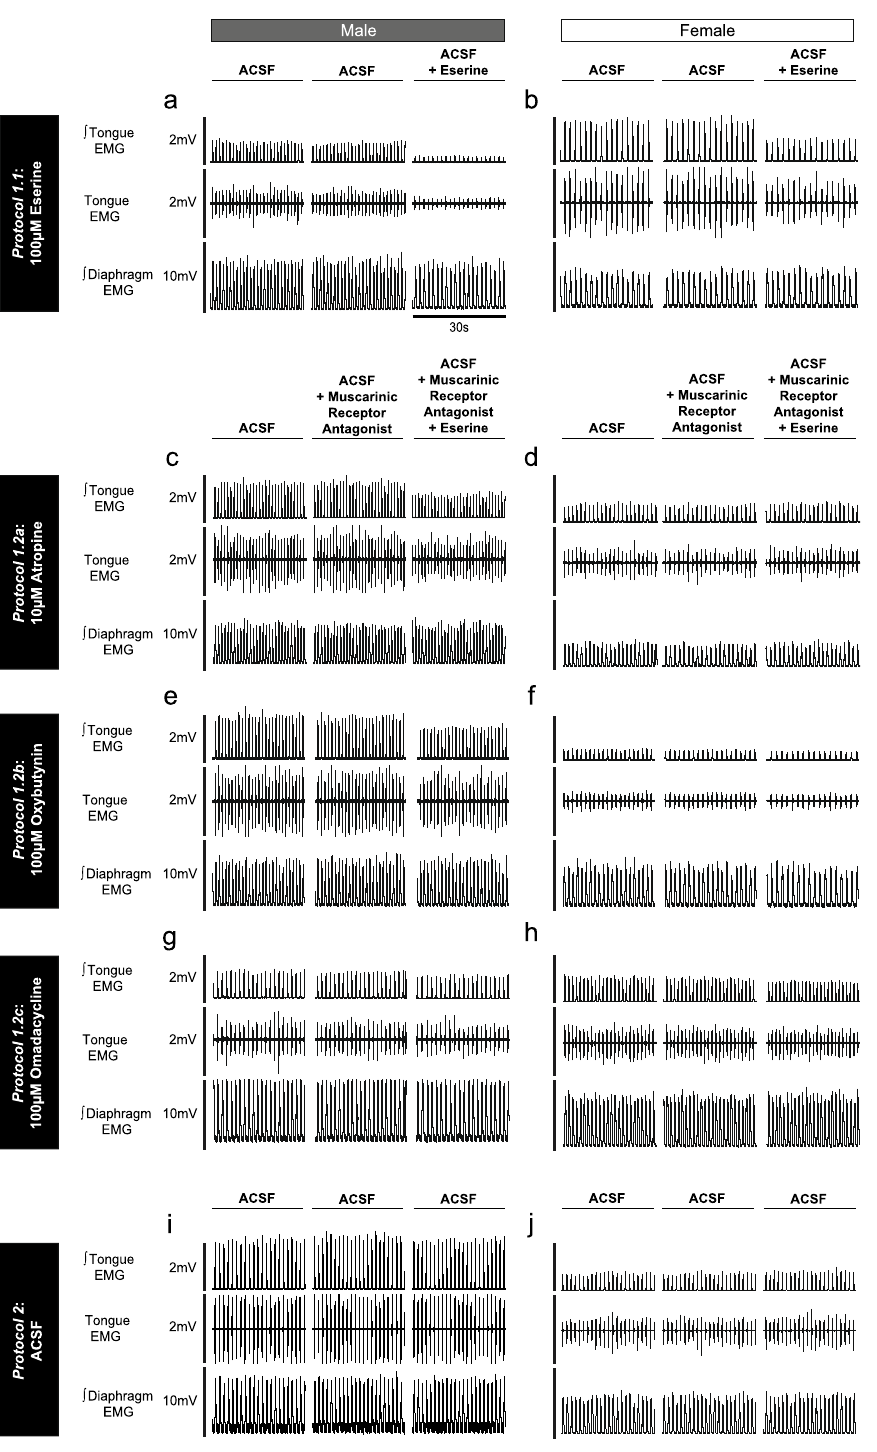
Figure 2. Example traces showing tongue motor inhibition by eserine at the HMN ( Protocol 1.1 ), the capacity for its blockade by muscarinic receptor antagonists ( Protocol 1.2a‑c ), and respiratory muscle activities over sequential ACSF (i.e., sham) time control interventions ( Protocol 2 ). The sets of traces ( a – j ) show the raw tongue EMG activity, and the moving time averages (∫) of tongue and diaphragm EMG signals for males (left column) and females (right column). The indicated variables and their scales on the ordinate axes for the left panels (males) are the same as for the adjacent panels on the right (females). The 30-s sample traces represent the last minute of each intervention, with this last-minute period used for data